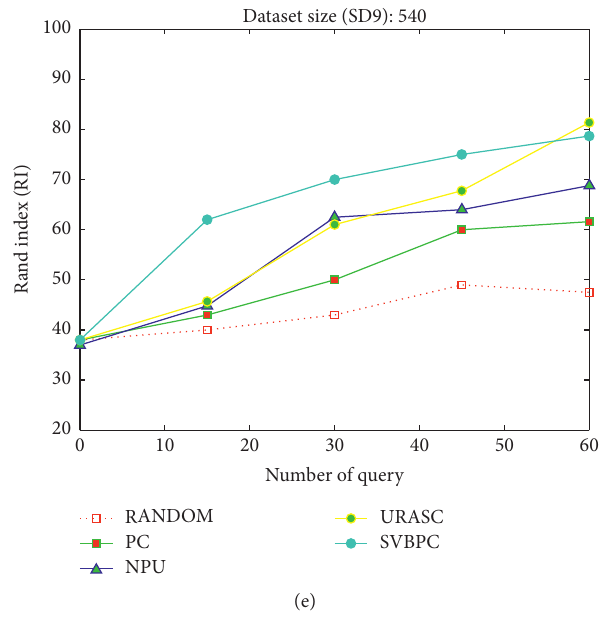
Figure 2: RI details on the proposed algorithm. Table 3: Problems and solutions for handling reduction of accuracy by increasing the number of pairwise constraints. Problems Solutions Effect of the disarrangement of pairwise constraints in a presentation to Oracle for reducing accuracy